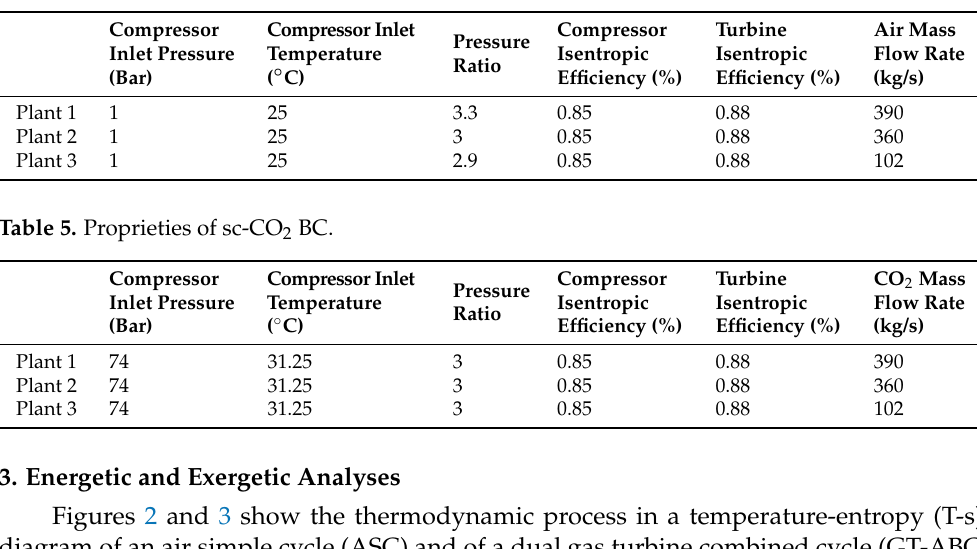
Table 4. Proprieties of ABC with optimal air mass flow rate.